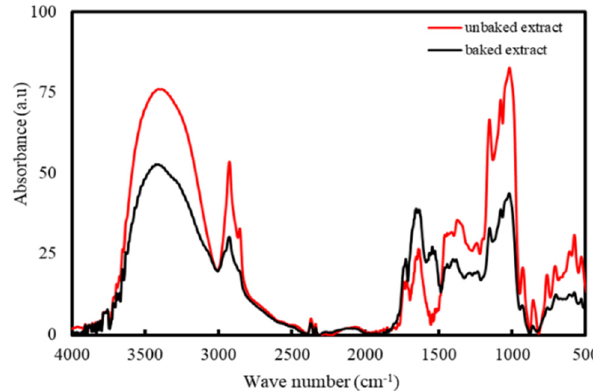
Figure 6. FTIR spectra of the unbaked and baked extract of Cilembu sweet potatoes.